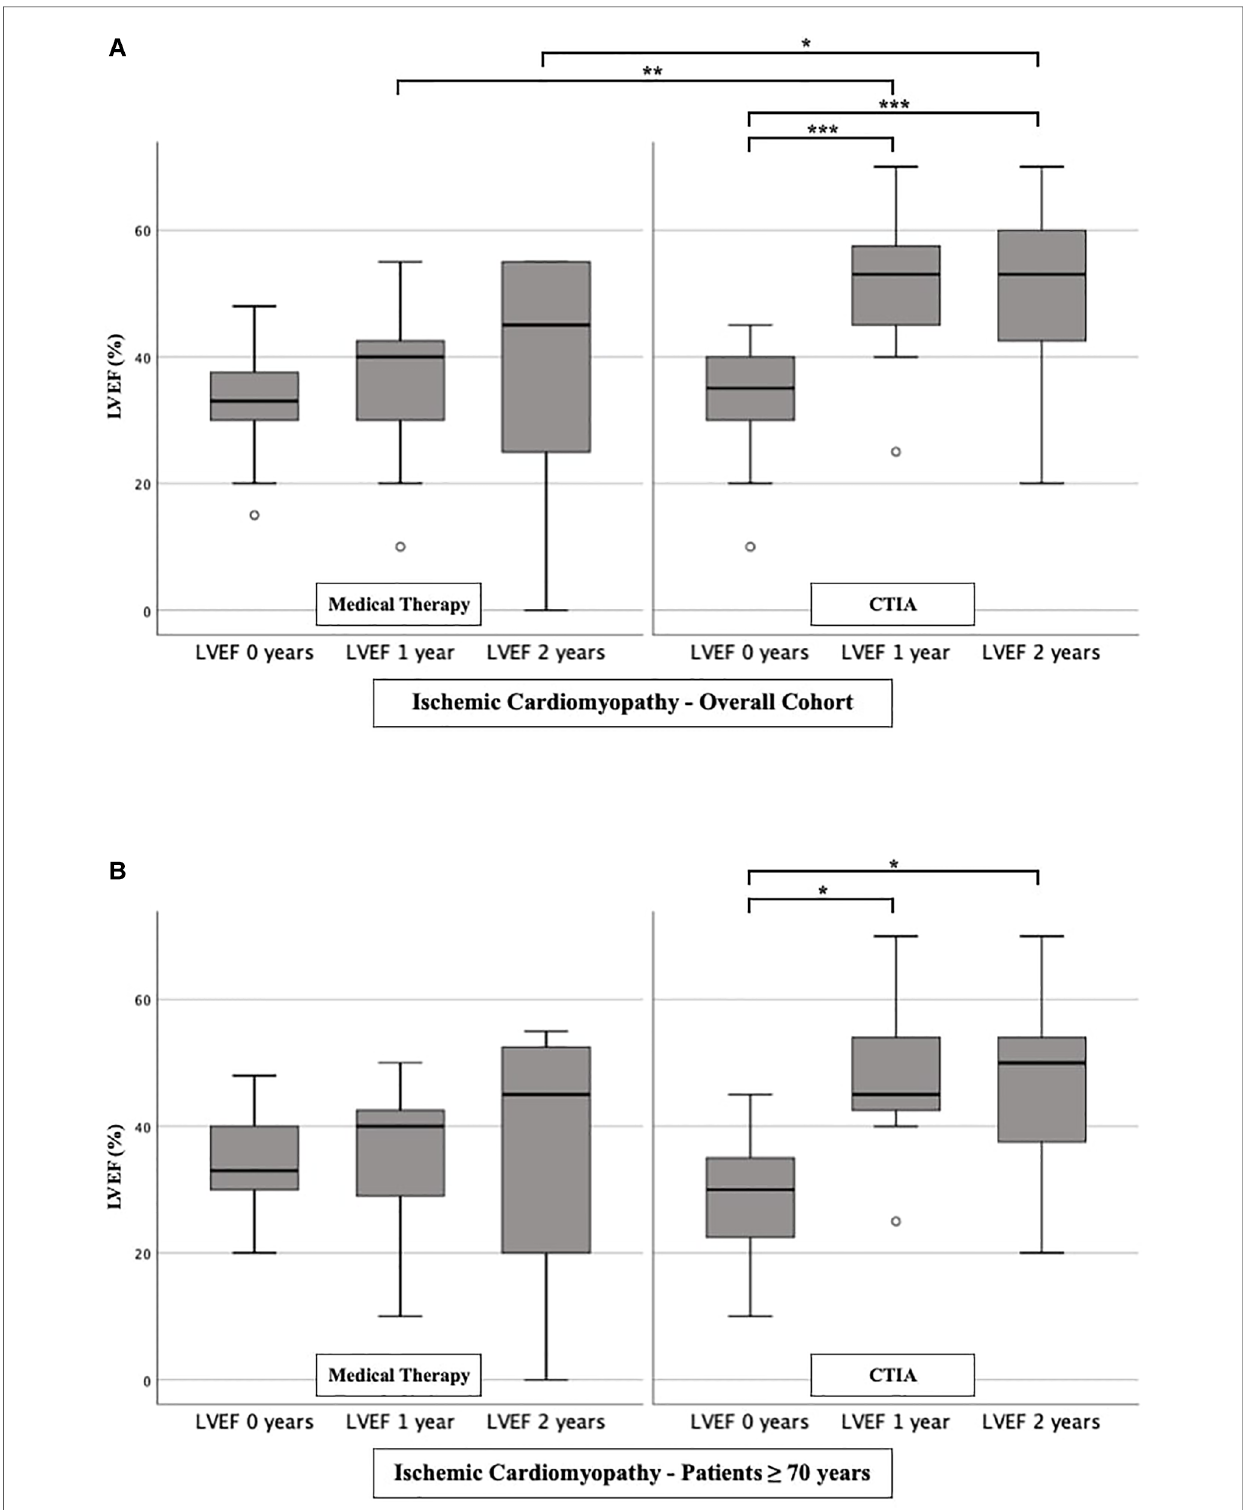
FIGURE 3 LVEF modi fi cations in medical therapy group vs. ablation group of patients with ischemic cardiomyopathy. ( A ): All patients with ischemic cardiomyopathy. ( B ): Patients ≥ 70 years with ischemic cardiomyopathy. * p ≤ 0.050; ** p ≤ 0.010; *** p ≤ 0.001.